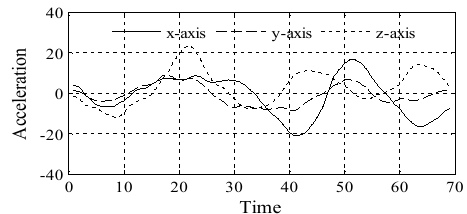
Figure 6. Original Gesture Data